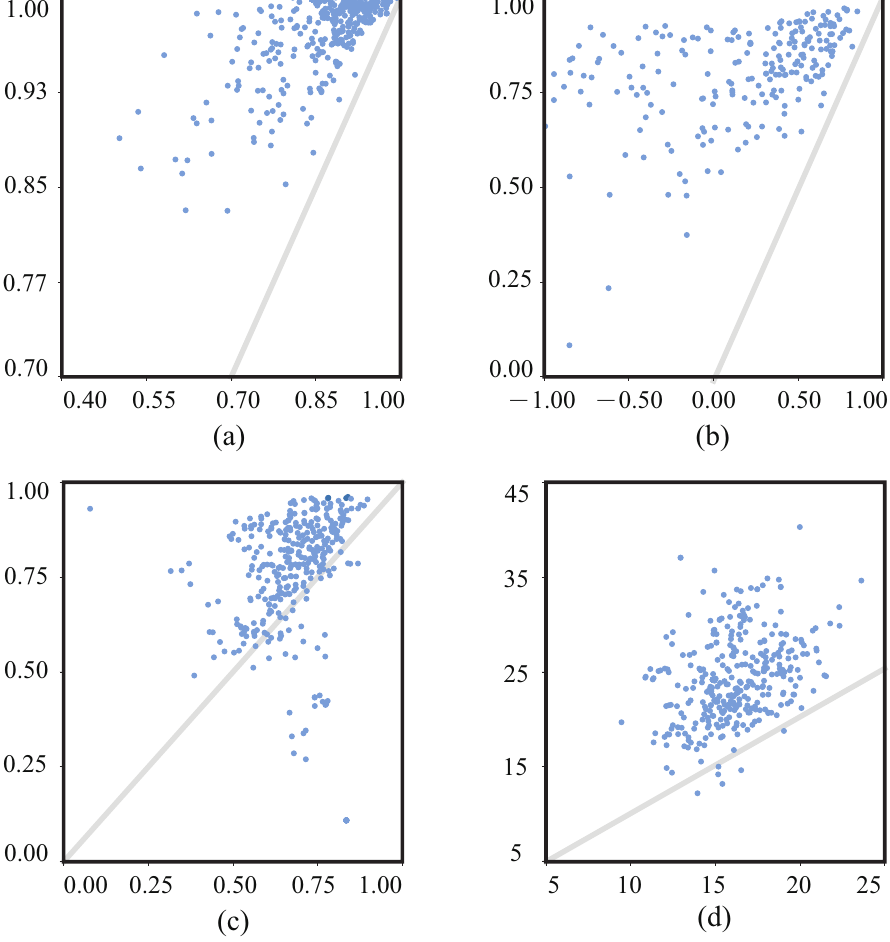
Figure 18. Index values before (X-axis) and after (Y-axis) processed by self-attention U-Net. ( a ) PCC, ( b ) R 2 , ( c ) SSIM, ( d )